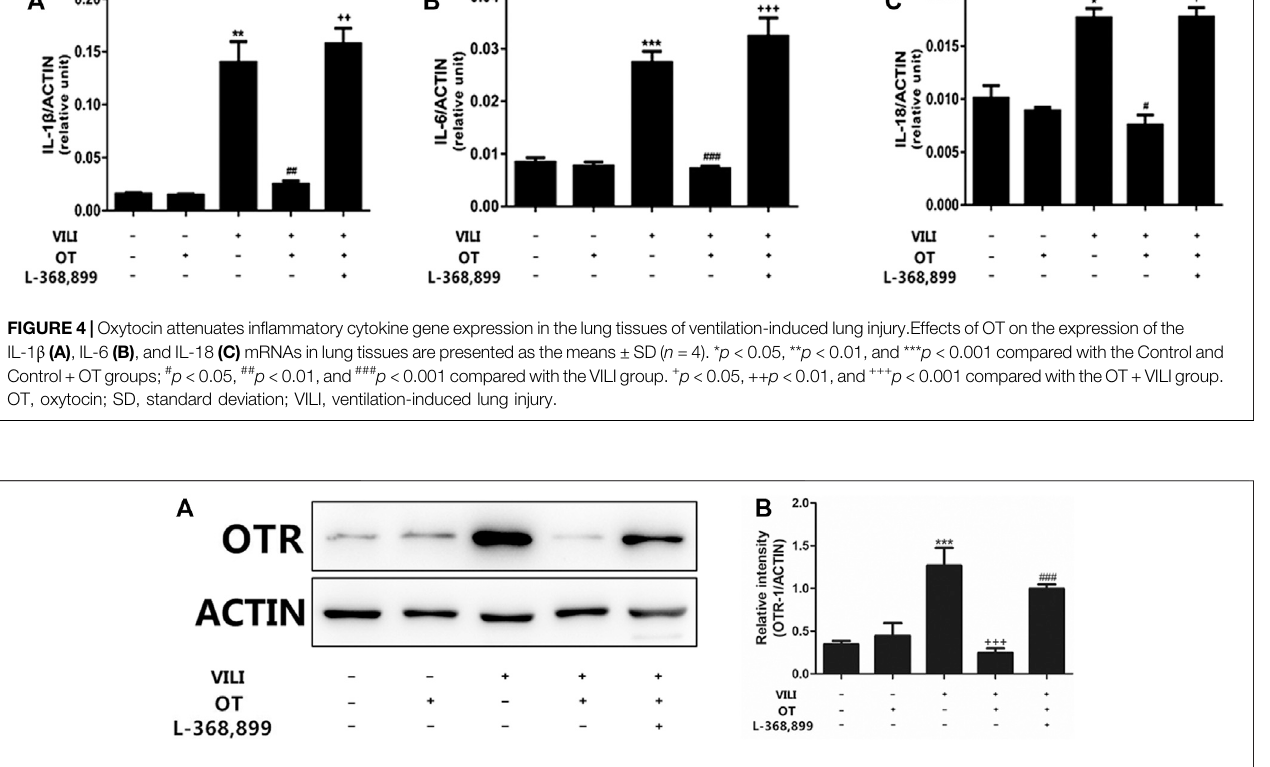
Frontiers in Pharmacology |